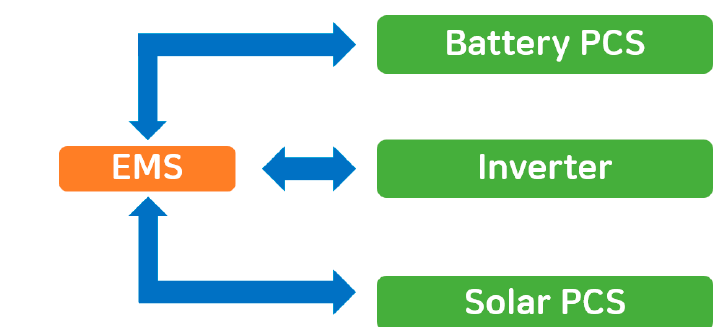
Figure 2. Communication method of microgrid system. PCS—power conversion system.